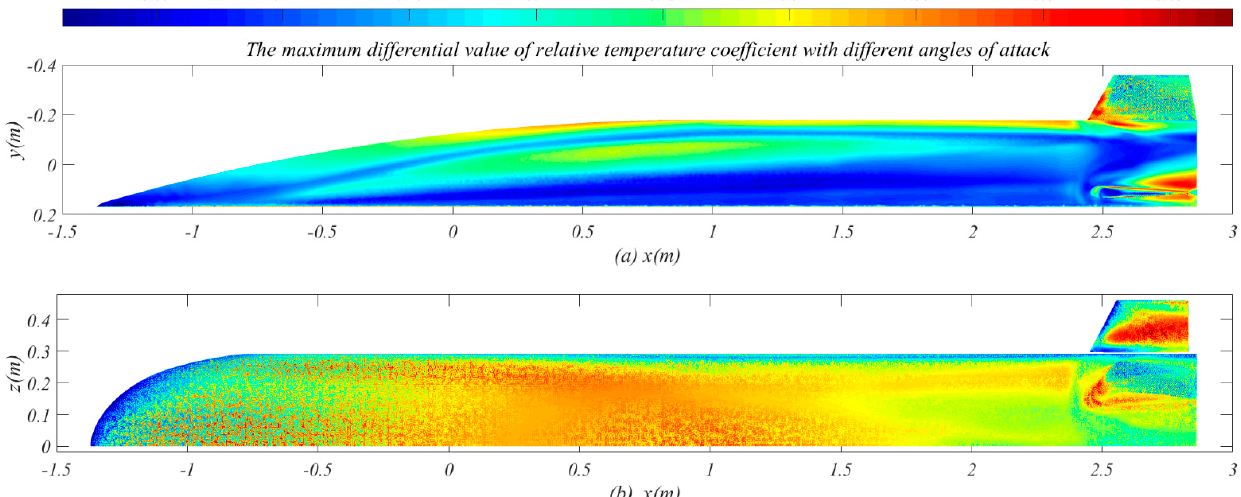
Figure 10. The maximum differential value of relative temperature coefficient with different angles of attack: ( a ) the side view of aircraft; ( b ) the top view of aircraft.